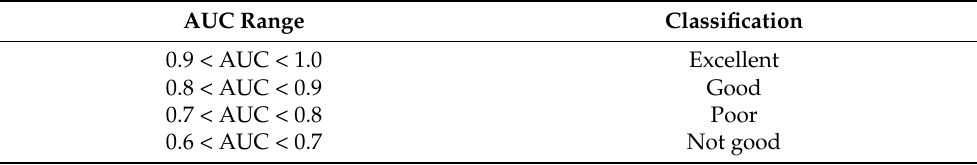
Table 2. Scale of classification by AUC